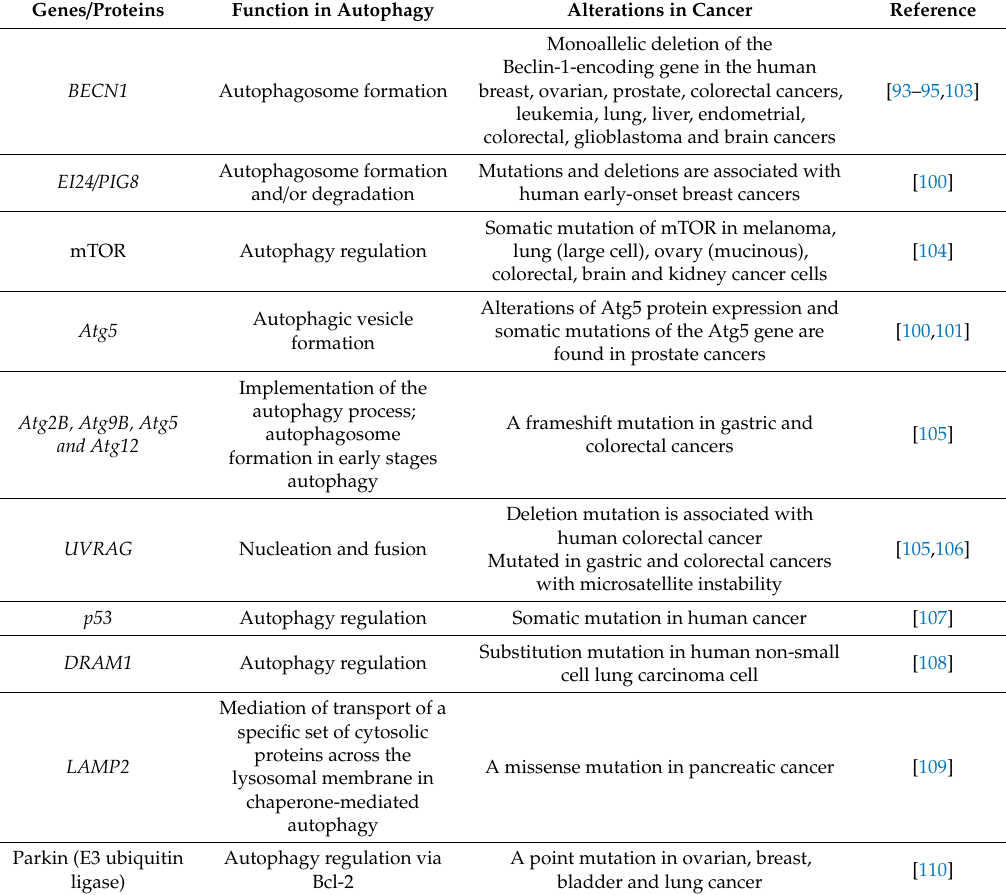
Table 1. Dysregulated autophagy genes / proteins in